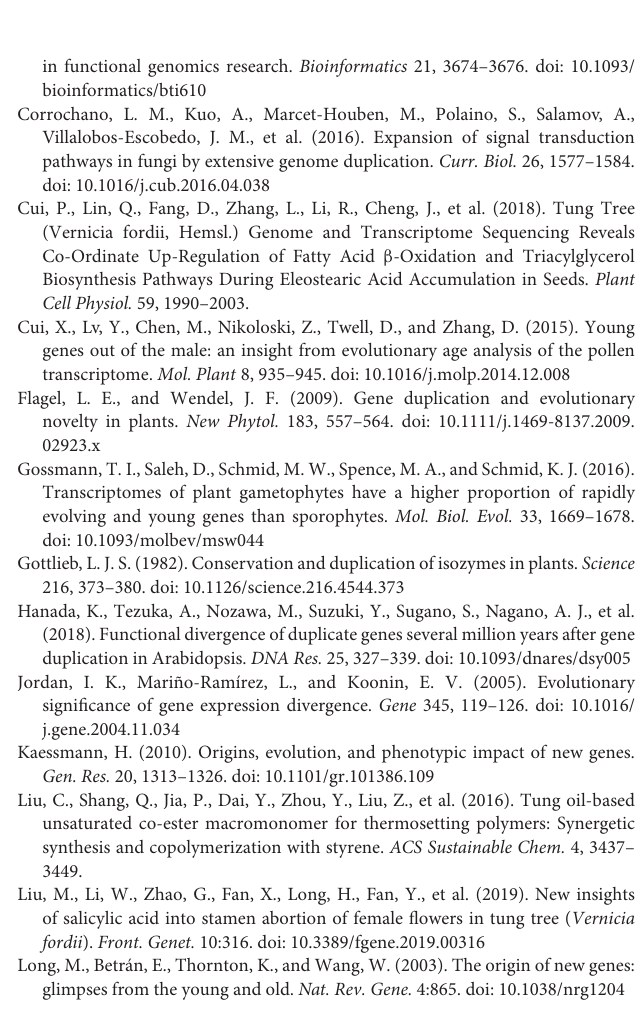
Supplementary Figure 1 | Correlation analysis of gene complexity, gene expression breadth, gene expression level, and substitution rate between young and old duplicate genes in Vernicia fordii . The figure was constructed using the gplots package in R. 10_WAF, 15_WAF, 20_WAF, 25_WAF, and 30_WAF represent 10, 15, 20, and 25 weeks after flowering, respectively. C1, C2, C3, and C4 represent 30, 20, 10, 1 days before female flowering, respectively. X1, X2, X3, and X4 represent 30, 20, 10, 1 days before male flowering, respectively. CX means hermaphrodite. Supplementary Figure 2 | Comparisons of the number of gene ontology (GO) terms between young and old duplicate genes in Vernicia fordii . Supplementary Table 1 | Specific gene ontology terms for cell components between young and old duplicate genes in Vernicia fordii